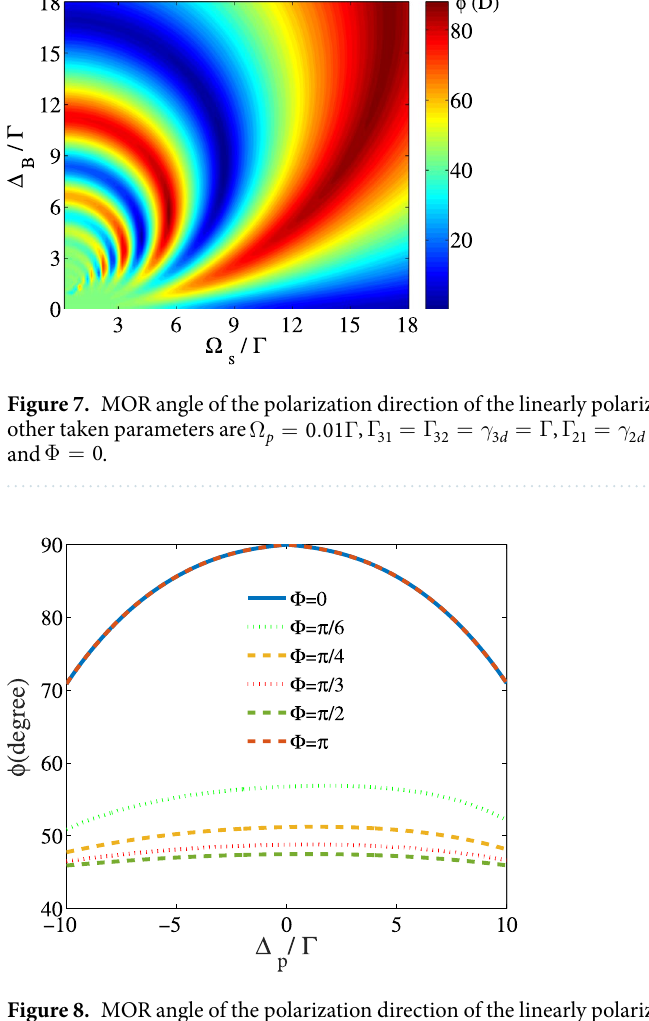
Figure 8. MOR angle of the polarization direction of the linearly polarized probe field versus detuning of the probe field for different values of the relative phase of the applied fields. The taken parameters